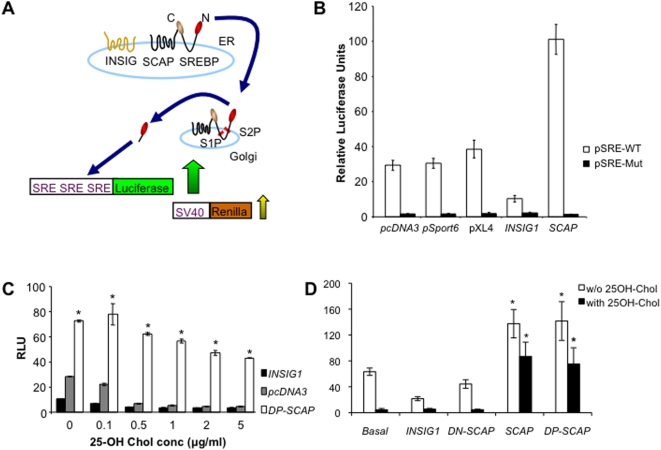
The SREBP cleavage assay.(A) Schematic representation of the SREBP cleavage assay. (B) Activity of wild-type (WT) versus mutant (Mut) SRE promoter. HEK-293 cells were set up in a 96-well plate (in triplicate). After 24 hours, cells were transfected with either WT (open bars) or mutant (black bars) luciferase reporter constructs, along with renilla luciferase construct and the indicated plasmid /cDNA. Cells were grown for an additional 24 hours before performing the assay. (C) Effects of 25-hydroxy cholesterol (25-OH chol.) on SREBP signaling. The assay was carried out under varying 25-OH cholesterol concentrations (0.1–5 µg/ml) and for different incubation periods (6, 12, and 24 hours). 25-OH chol. was added to cells 1 day after transfecting with the reporter plasmids, SRE-luciferase and renilla luciferase. Maximum suppression of SRE-luciferase signals was observed after 24 hours of incubation with 25-OH chol (shown here). The effects of DP-SCAP under high 25-OH cholesterol levels are significantly higher at all concentrations (Student's t-Test, p<0.005). (D) Effects of known repressors, activators and high cholesterol (25OH chol., 1 µg/ml) on the SREBP signaling pathway. The assay was carried out as in B. Basal refers to pcDNA3 overexpression. SCAP and DP-SCAP significantly activate the assay in the absence (white bars) or presence (black bars) of 25-OH cholesterol (Student's t-Test, p<0.05). (B–D) Error bars indicate standard deviations (n = 3). Where not visible, error bars are smaller than symbols. The graphs are representative of at least 2 independent experiments.